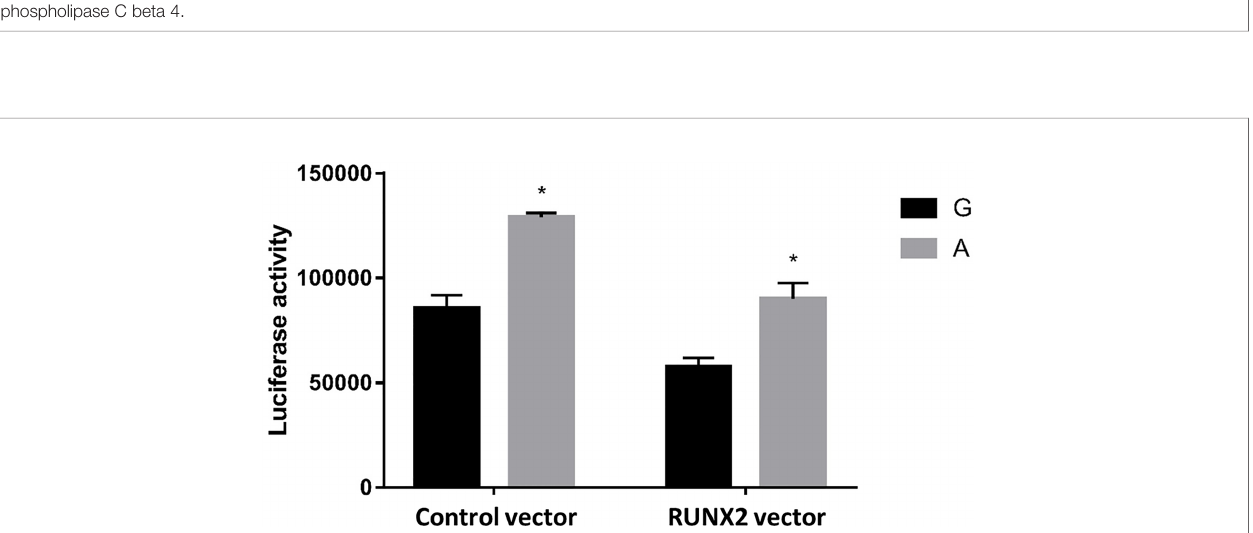
FIGURE 4 | Effects of the rs6086746 genotype on luciferase activity in cultured HEK293cells. HEK293 cells were transfected with 0.5 m g pGL3 basic-LUC luciferase reporter recombinant plasmids containing a PLCB4 promoter sequence with the wild-type G allele or A allele at the rs6086746 SNP in the presence of 0.5 m g pSG5.HA control vector or pSG5.HA.RUNX2 vector. Transfected cells were cultured for 24 h. Luciferase activity in cell extracts was expressed in relative light units (RLUs). Mean ± SEM is given for each construct from three experiments. *p < 0.05.